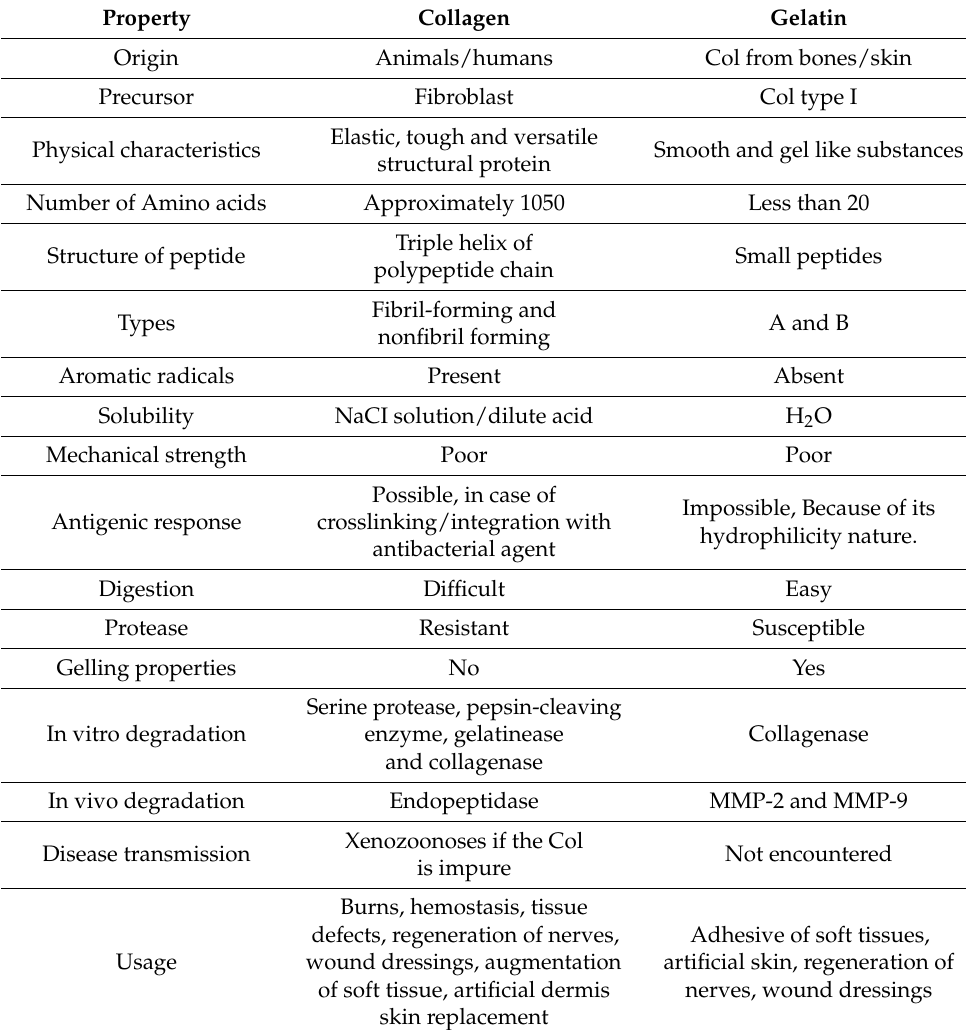
Table 1. Differences between collagen and